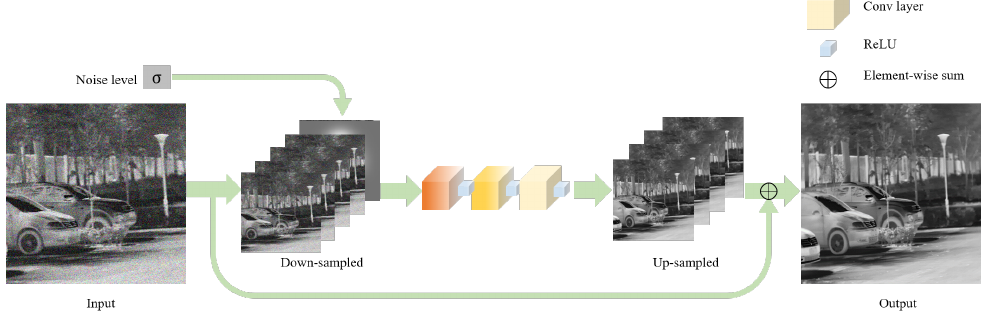
Figure 4. Network structure of the proposed deep infrared denoising prior.